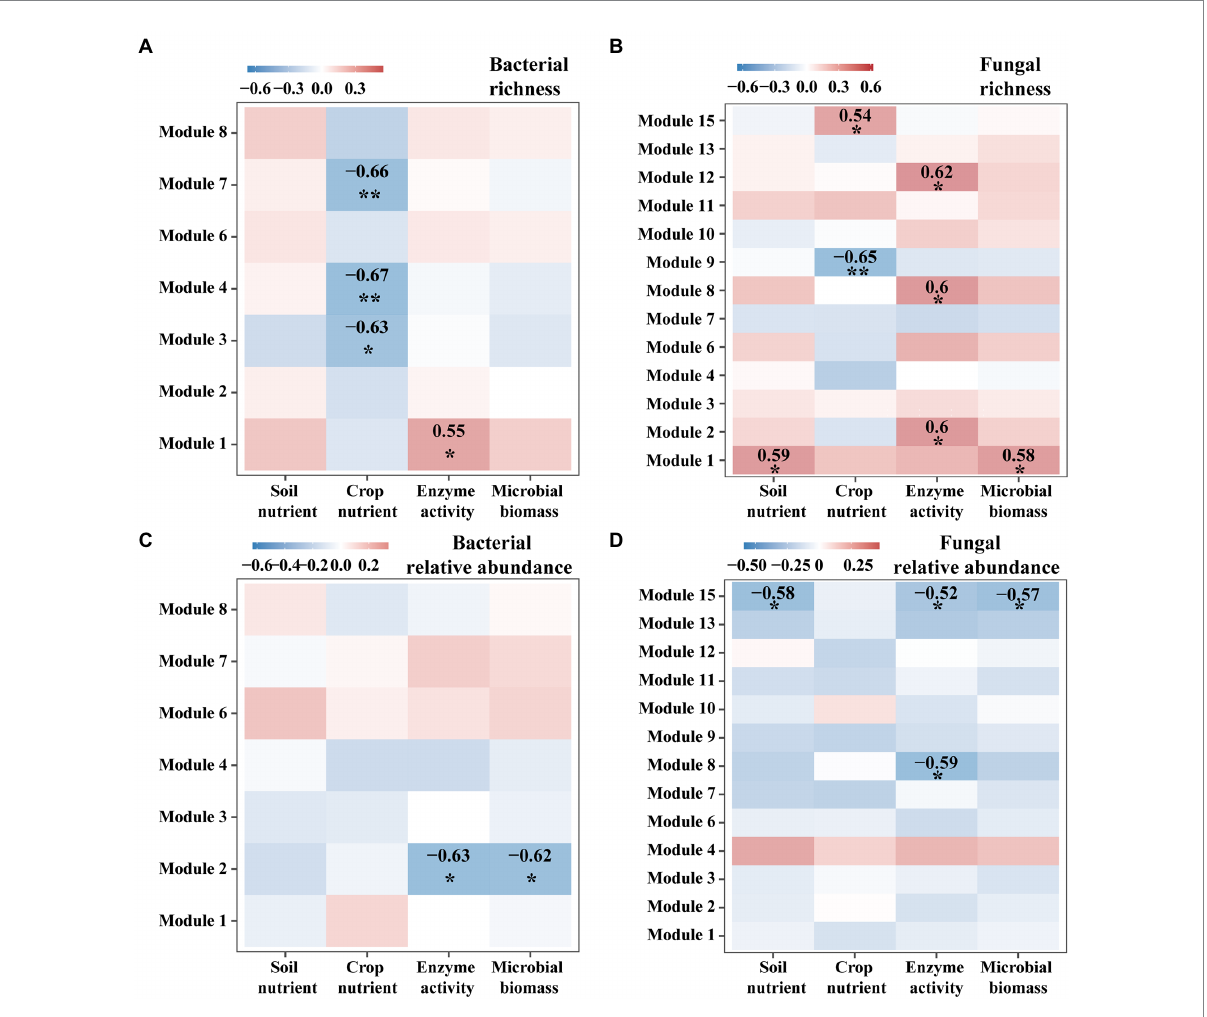
FIGURE 5 The heatmap for Spearman relationships between ecosystem multifunctionality and the characteristics of microbial modules. We considered four groups of ecosystem multifunctionality such as soil nutrient, crop nutrient, enzyme activity and microbial biomass. We considered two characteristics for each module of bacteria (A,C) or fungi (B,D) : Species richness (A,B) and the relative abundance (C,D)